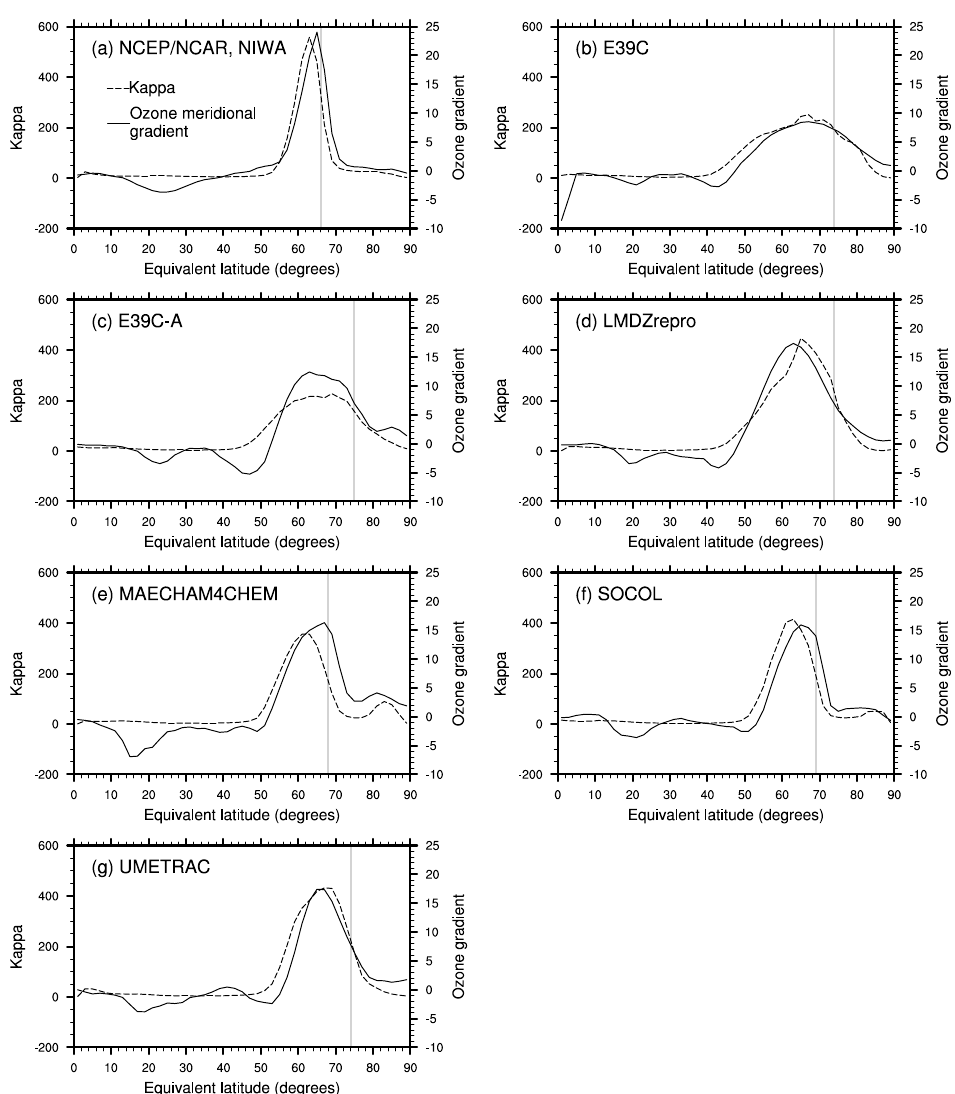
Fig. 5. Comparison of the five year (1995–1999) average κ (dashed line) and the negative of the gradient in total column ozone with respect to equivalent latitude (solid line). (a) NCEP/NCAR reanalyses and NIWA observation data-base, (b) E39C (c) E39C-A, (d) LMDZrepro, (e) MAECHAM4CHEM, (f) SOCOL and (g) UMETRAC. The gray vertical lines indicate the average position of the inner vortex edge for each model (see Table 2).